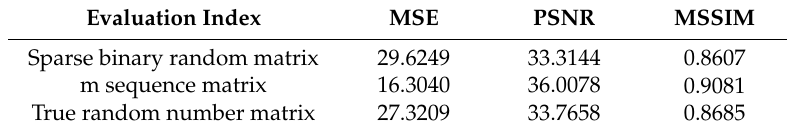
Table 1. Evaluation indices of reconstruction image under different measurement matrices.